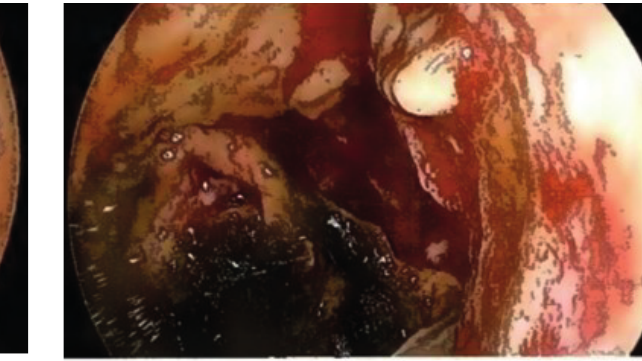
Figure 2. FNE showing further ulceration and